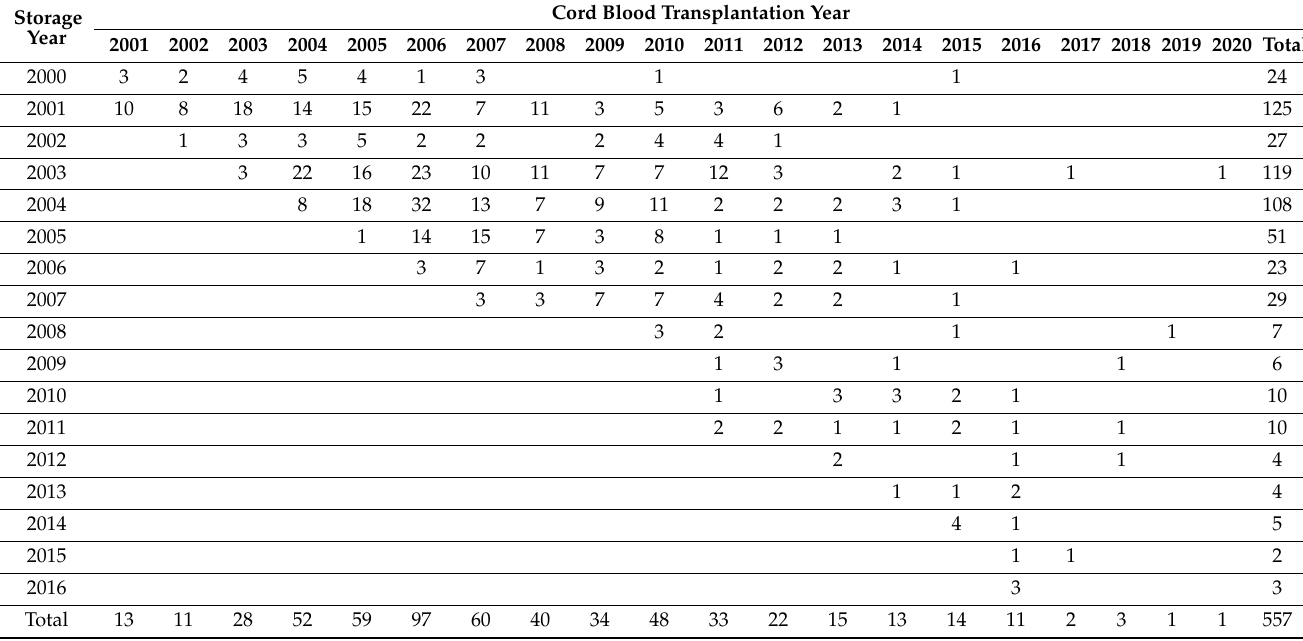
Table 4. The number of CB units according to the transplantation and storage